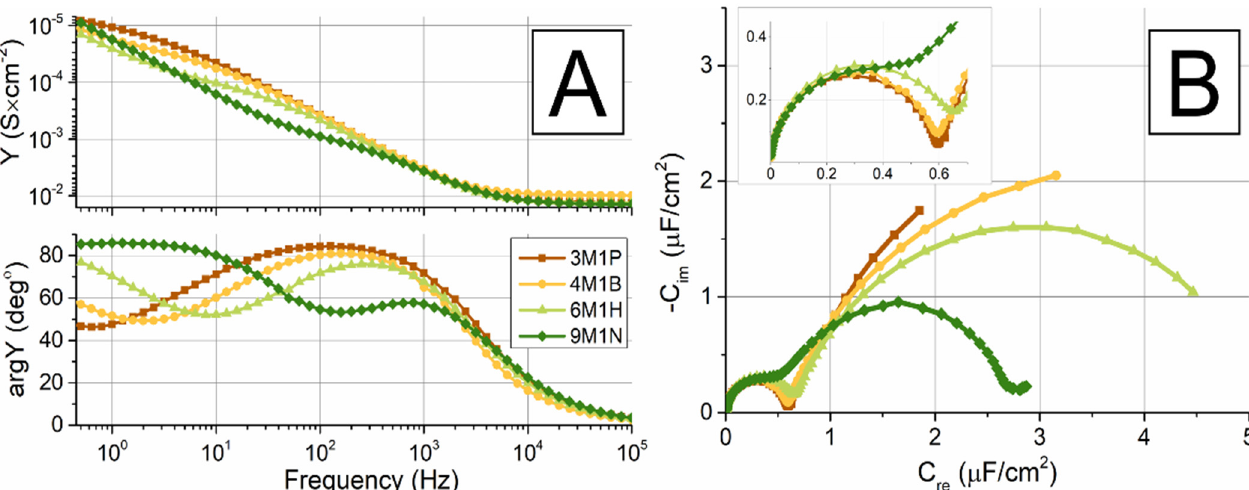
Figure 7. The formation of tBLM on mixed WC14/backfiller SAMs. EIS data of DOPC/Chol (ratio 60:40%) tBLM composed on mixed WC14/backfiller (in ratio 20:80%) SAMs, containing different backfillers: 3M1P, 4M1B, 6M1H, and 9M1N. ( A ) Admittance modulus (upper panel) and phase (lower panel) (Bode) plots ( B ). Capacitance values of tBLMs with different backfillers and WC14 anchors. Inset shows an enlarged area of the plot with a higher frequency (100 kHz to 30 Hz). Full frequency range 100 kHz–0.1 Hz.